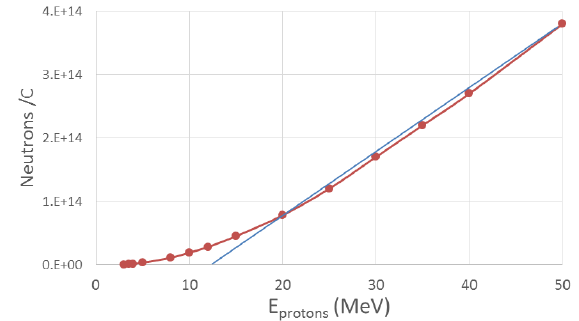
Fig. 1. Neutron yield as a function of the proton energy on a beryllium target (ENDF database).